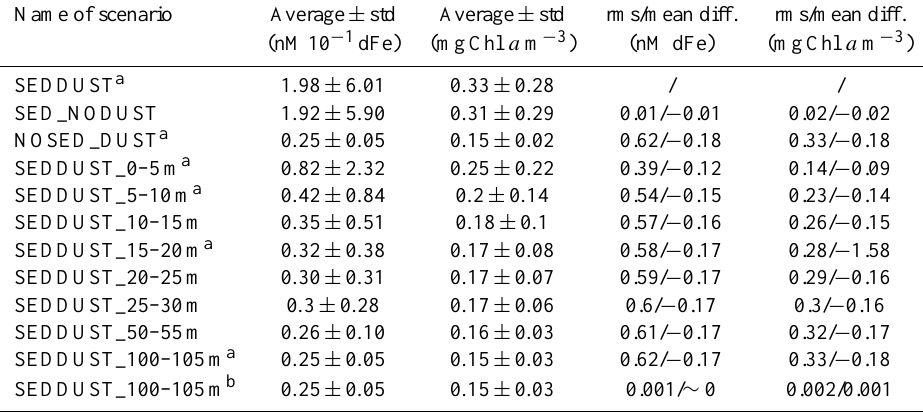
Table 1. Averages of surface dFe and Chl a concentrations from each sensitivity run and from the domain around South Georgia depicted in Fig. 7a. rms and mean differences between each sensitivity run and the SEDDUST scenario are also indicated. Name of scenario rms/mean